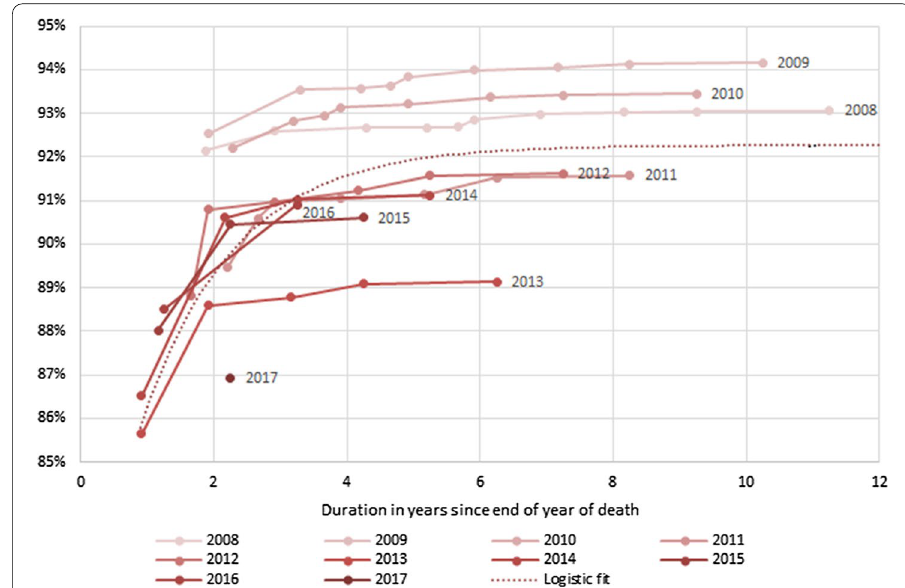
Fig. 1 Completeness of registration by years since death for each annual release of the cause-of-death data 2008–2017. Each line tracks the monotonic increase in registration of deaths from the first annual report on the year. Each point represents the completeness after adding late registrations reported in the subsequent annual